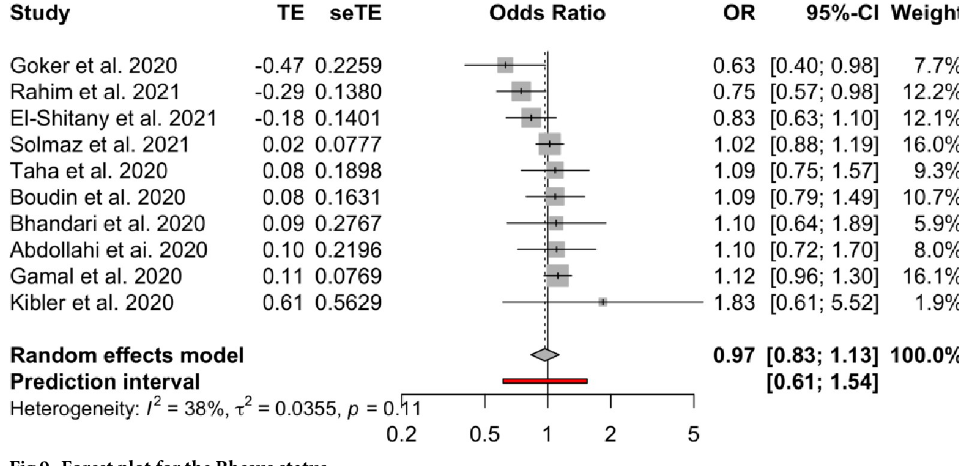
Fig 9. Forest plot for the Rhesus